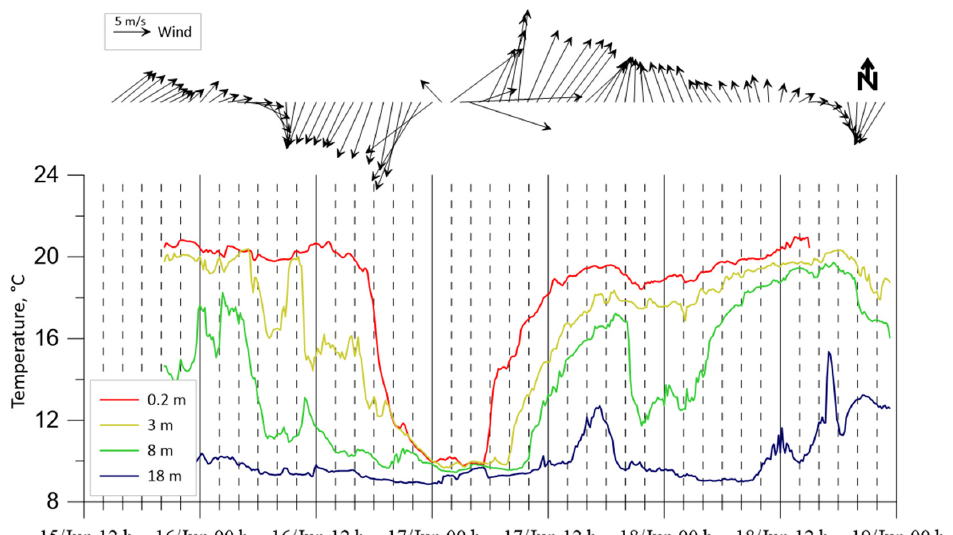
Figure 9. Sharp temperature decrease in June 2021. Upper panel—wind speed. Lower panel—water temperature.